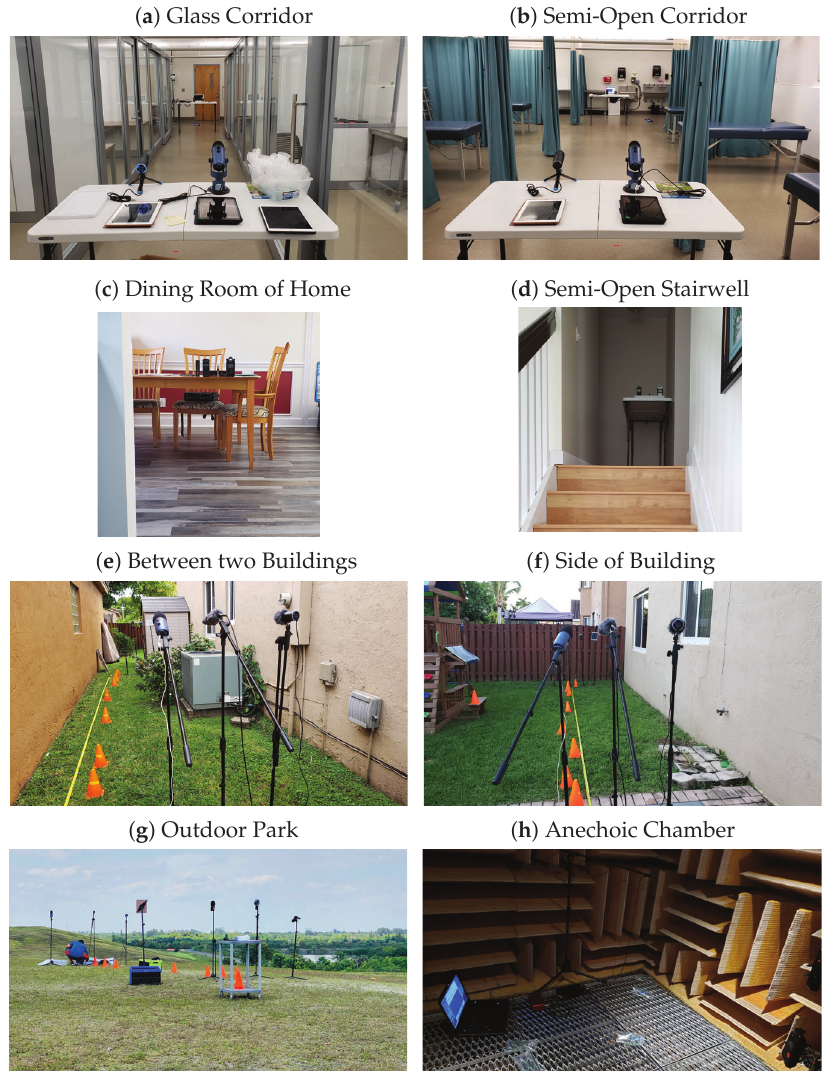
Figure 1. Images of the various environments